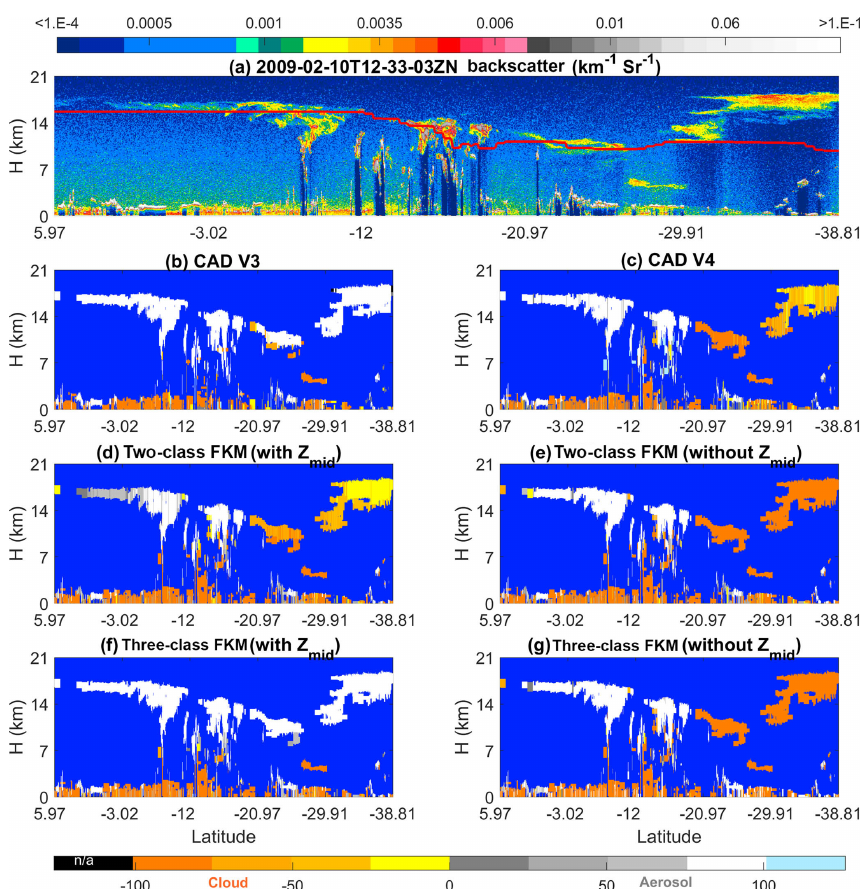
Figure 9. The top row shows 532nm attenuated backscatter coefficients for (a) measurements acquired on 10 February 2009 showing smoke injected into the upper troposphere and lower stratosphere by the Black Saturday fires in Australia. The solid line extending across panel (f) at altitudes between ∼ 7 and ∼ 8 . 5km shows the approximate tropopause altitude. The rows below show the CAD results reported by six different algorithms: the V3 operational CAD (b) , the V4 operational CAD (c) , the two-class CAD FKM with z mid (d) and without z mid (e) , and the three-class CAD FKM with z mid (e) and without z mid (j)